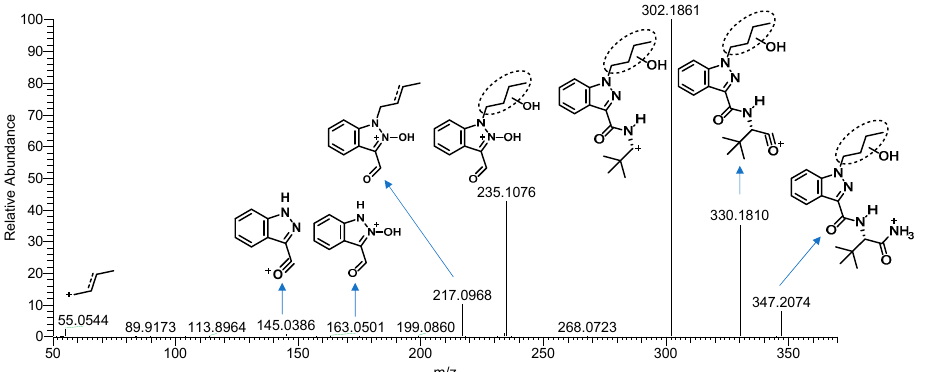
Figure 2. Mass spectrometry spectra and fragmentation of A1 (the monohydroxylated metabolite of ADB-BUTINACA, the wavy bonds position unassigned).